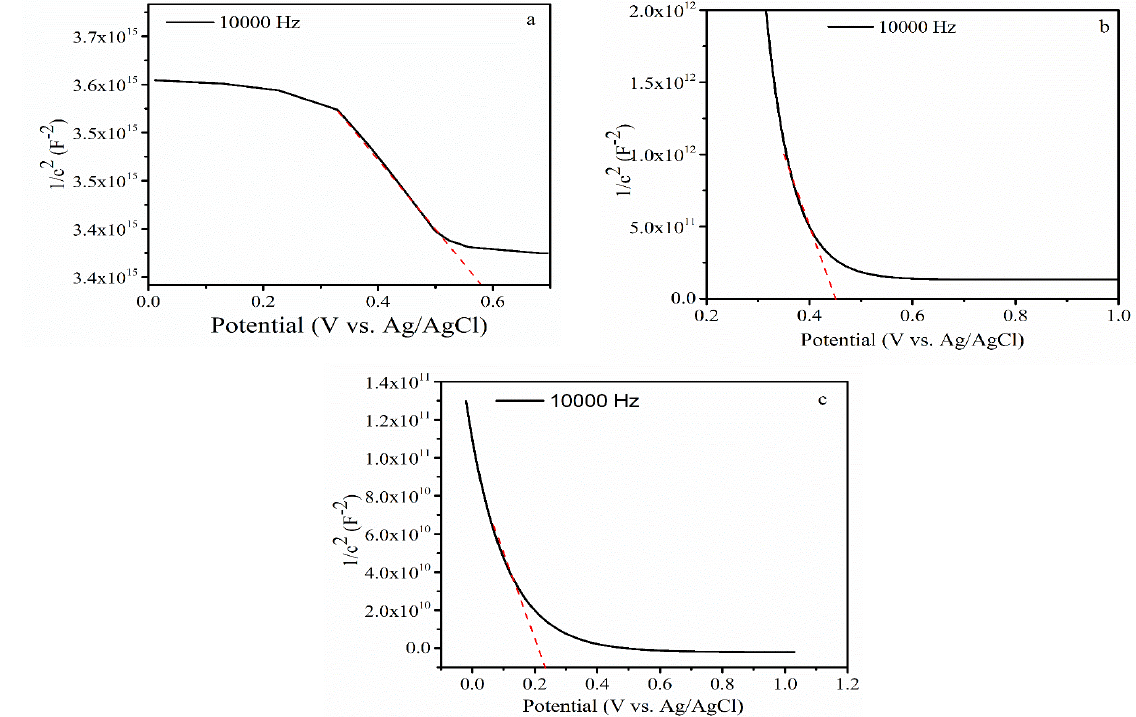
Figure 9: Mott-Schottky at a frequency of 10000 Hz in the dark plots of the (a) p-Si(100), (b) SiNWs photocathode prepared by etching 15 min, and (c) SiNWs photocathode prepared by etching 30